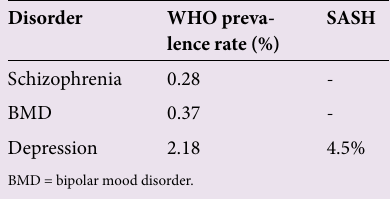
Table 1. Prevalence rates utilised in the